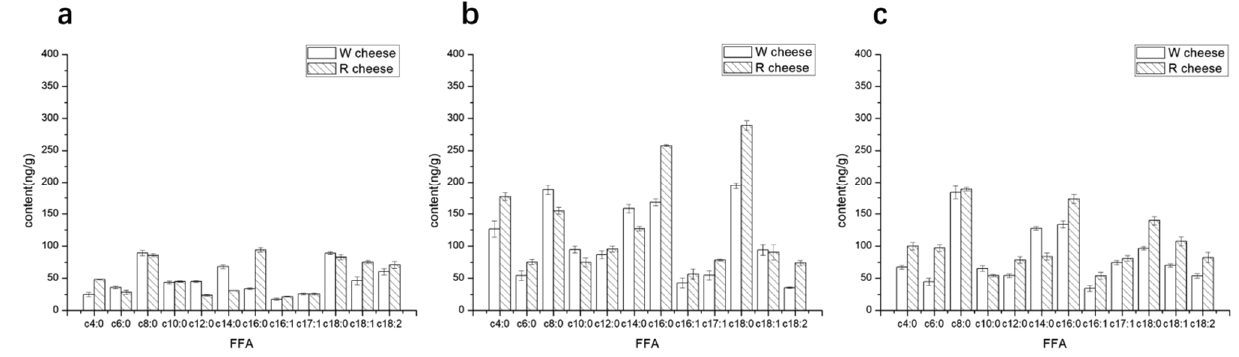
Figure 4. Content of individual free fatty acid (FFA) of cheeses with different ripening time. ( a ) 0 d; ( b ) 16 d; ( c ) 40 d.